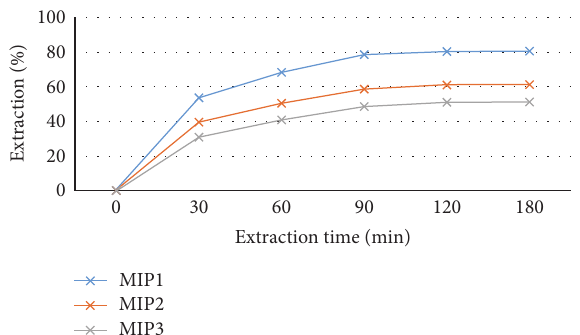
Figure 5: Cinnamic acid extraction efficiency depending on the extraction time between MIP1 and